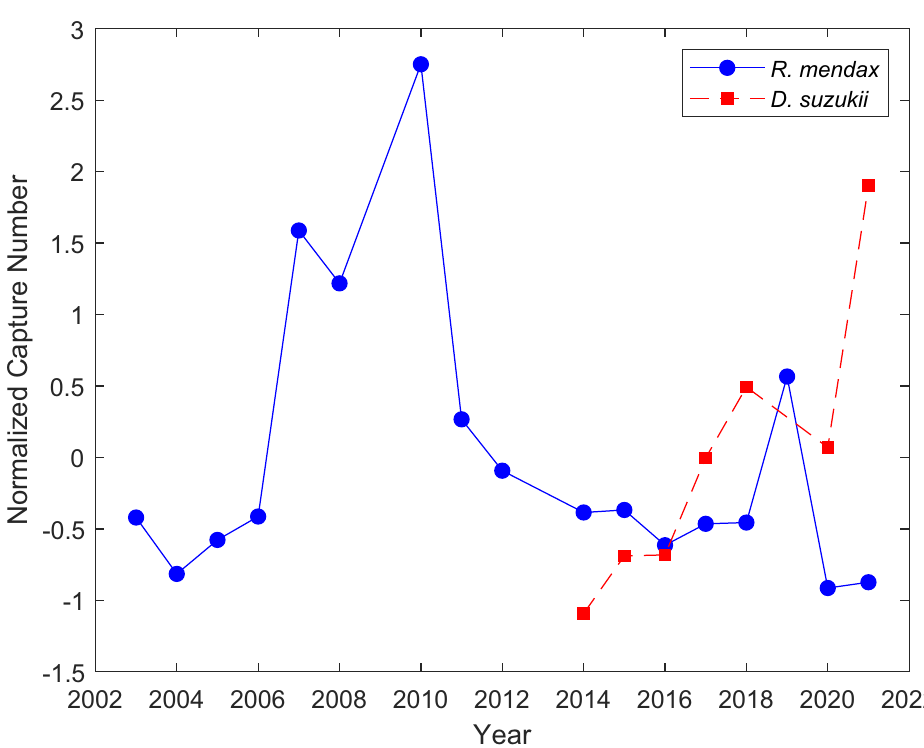
Fig 1. The annual normalized mean peak capture number of Rhagoletis mendax (solid blue line with blue circles), and mean midseason capture number of Drosophila suzukii (dashed red line with white squares), in highbush blueberry farms in New Jersey